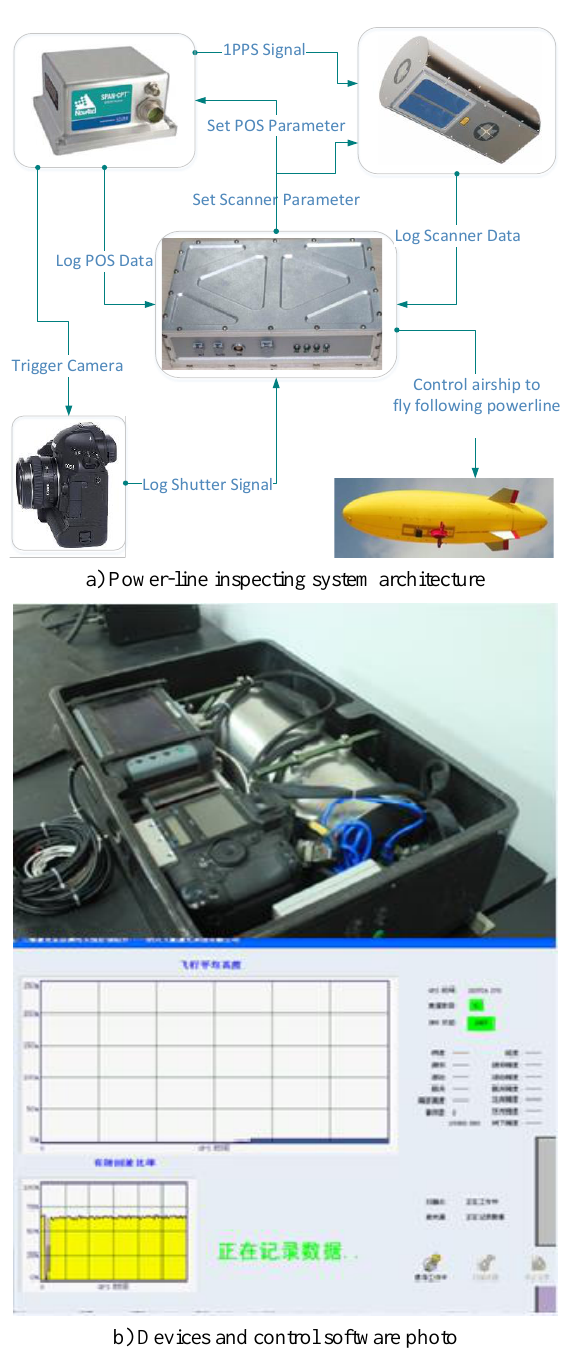
Figure 1. Architecture and photo of this compact LIDAR